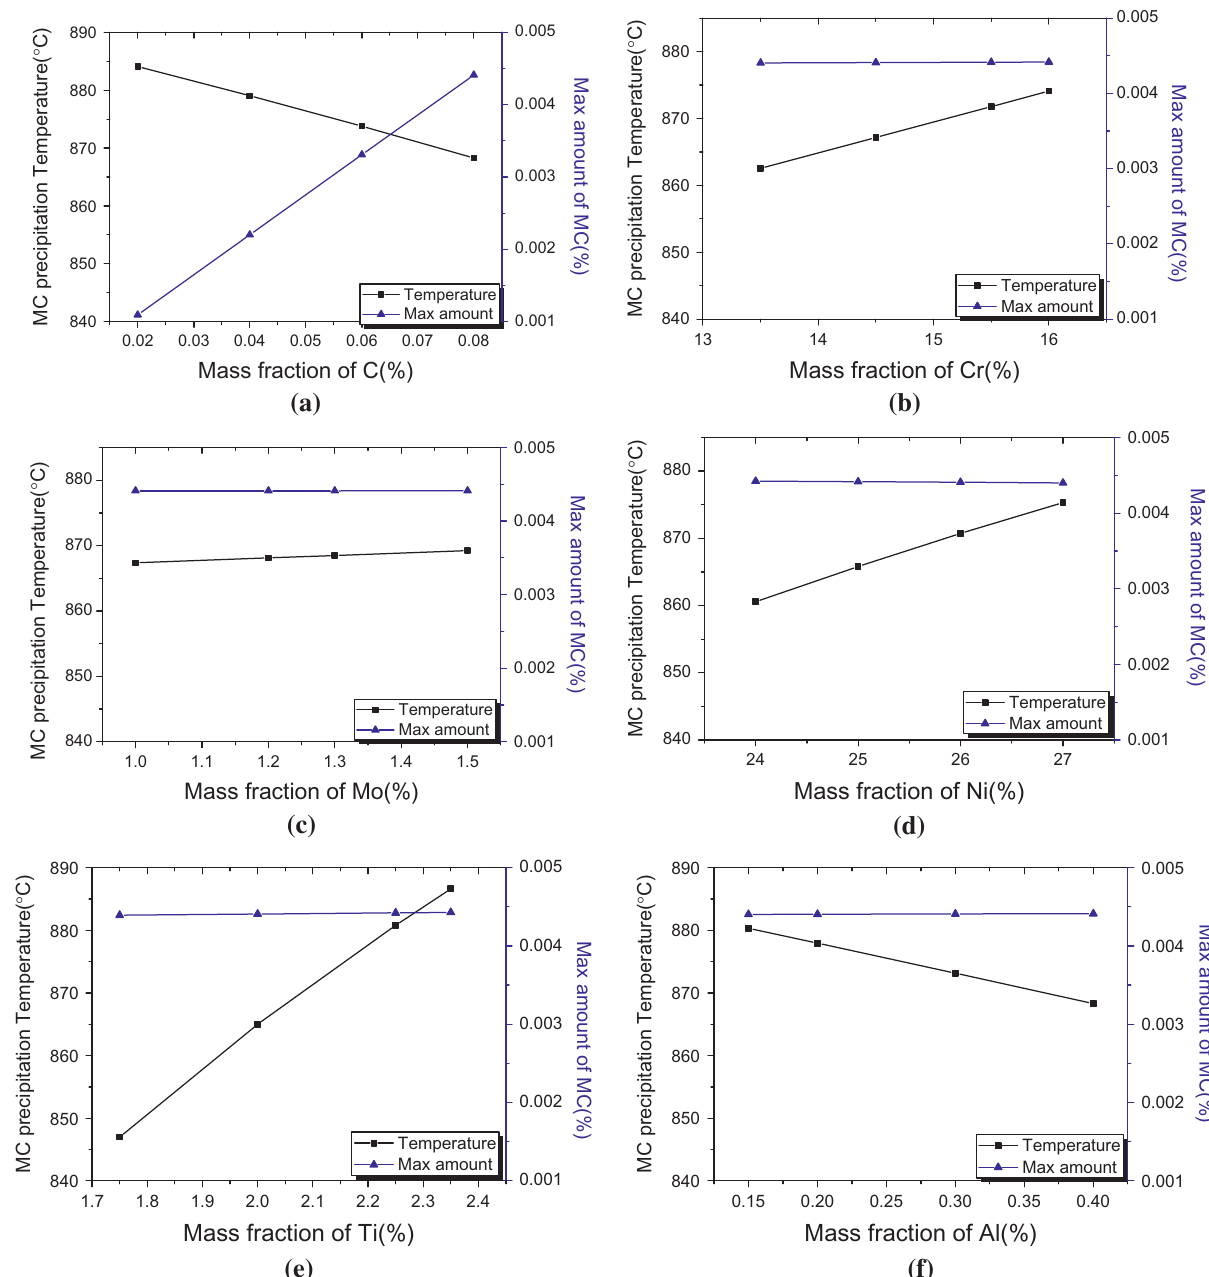
Figure 6: Variation of maximum amount and its corresponding precipitation temperature of MC phase with the contents of (a) C; (b) Cr; (c) Mo; (d) Ni; (e) Ti; (f)